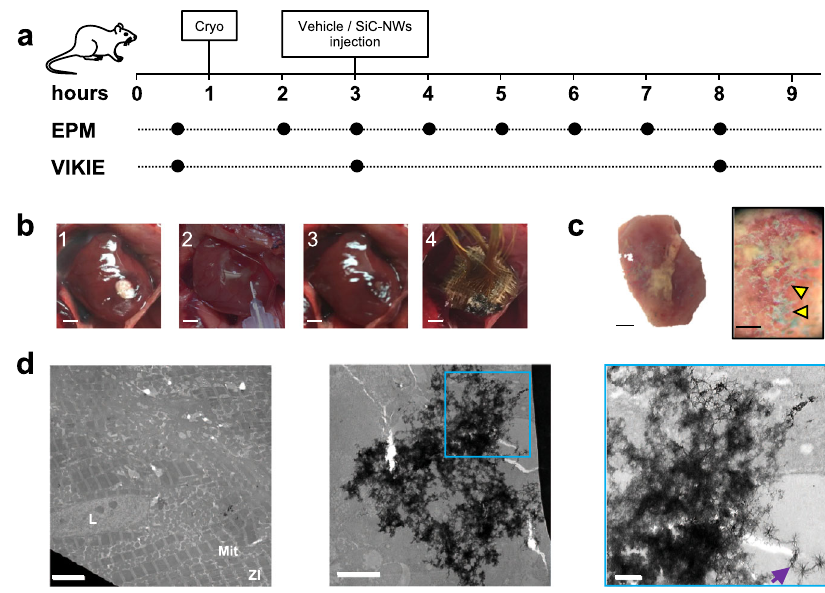
Fig. 6 Electrophysiological pro fi le of recovered sinus propagation in a cryoinjured portion of the heart via SiC-NWs myocardial injection. a Timeline of the experimental adopted protocol for providing in situ left ventricular cryoinjury (Cryo) and Vehicle/SiC-NWs injection. EPM: epicardial potential mapping recording. ViKiE Video Kinematic Evaluation recording. b Photographs of the in situ heart for the cryoinjury (1), SiC-NWs injection (2), injected area (3), and epicardial grid (4) covering the injured and the surrounding portion of the ventricle ( n = 10 experiments repeated with similar results); Scale bars: 2 mm. c Stereomicroscopy images of the transmural cryoinjured area (pale region left) containing 1 mg of SiC-NWs (yellow arrowheads, right); Scale bars: 500 µ m (left), 80 µ m (right). d TEM images of the infarcted cardiac tissue with SiC-NWs formed network. Left: macroscopic electron-dense images showing disorganized Z-lines (Zl), mitochondria (Mit), and capillary lumen (L). Middle and right images: area covered by the SiC-NWs network (zoomed